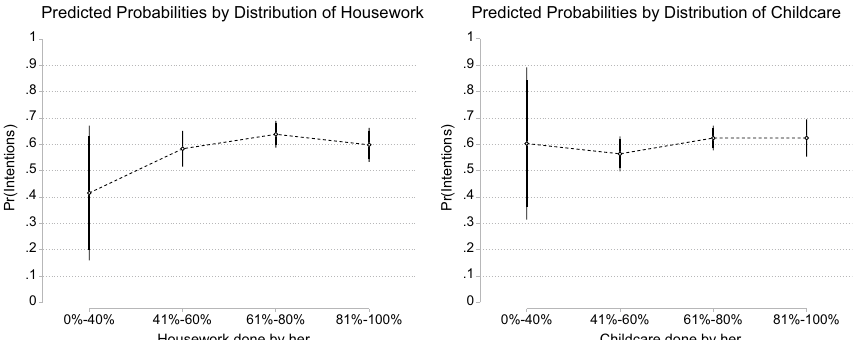
Fig. 8 Predicted probabilities of one-child mothers’ fertility intentions by housework/childcare distribution among mothers of children under 6. Error bars at 90% (thin) and 95% (thick). Models control for housework/ childcare duties done by other individuals, woman’s age, child’s age, migrant background, women’s attachment to the labour force, men’s labour force status, partners’ educational attainment, differences in educational attainment, partner’s children and partnership